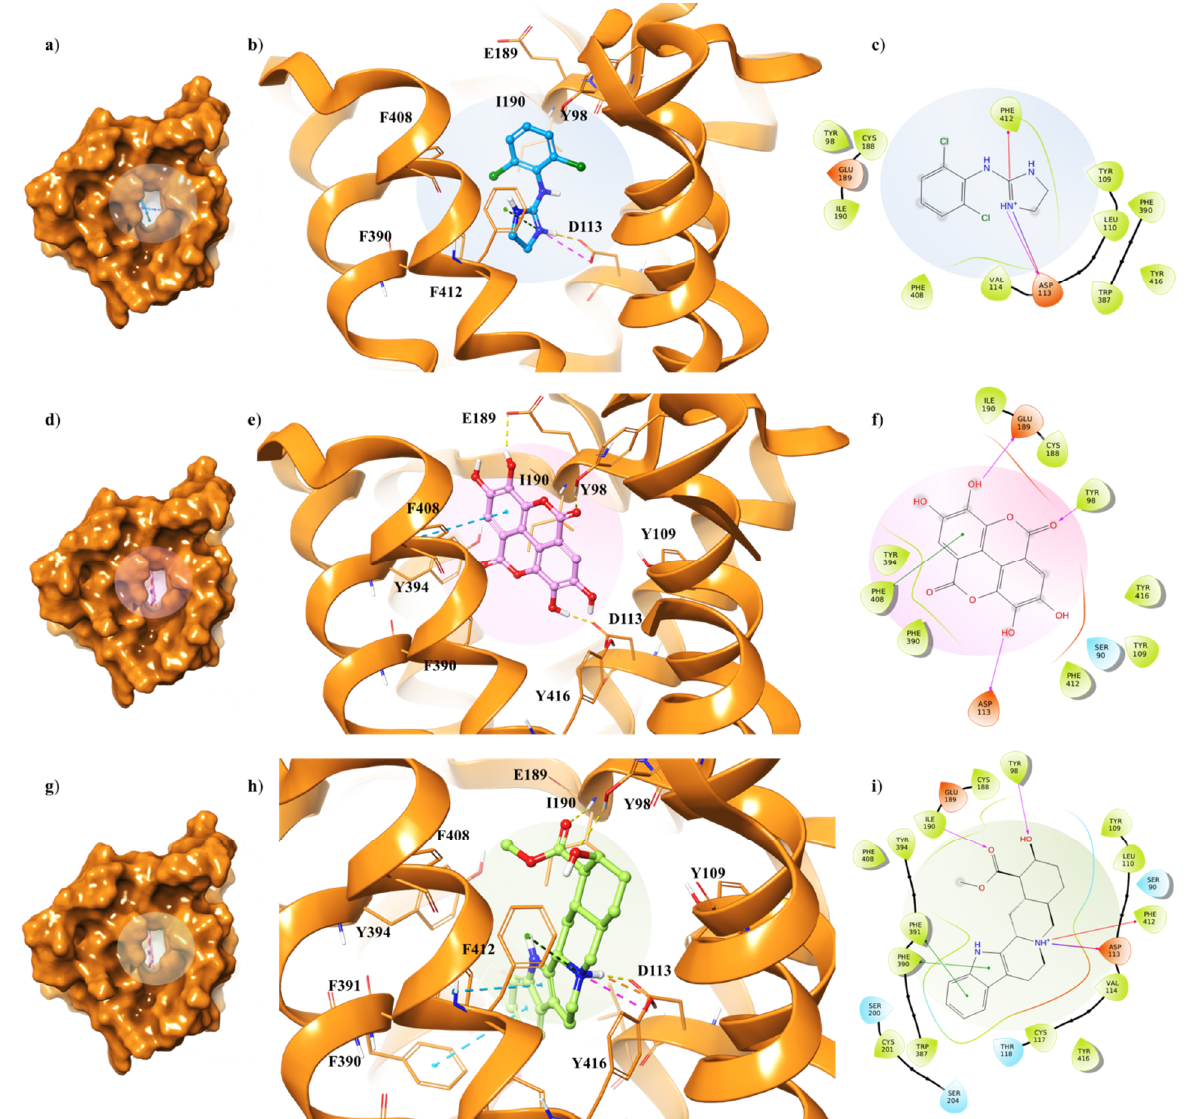
Figure 4. Key contacting elements inside ( a – c ) the α 2A -AR 6KUX /clonidine, ( d – f ) the α 2A -AR 6KUX /EA, and ( g – i ) the α 2A - AR 6KUX /yohimbine best docked pose. Panels ( b,e , h ) show all side chains involved in H-bonds (violet), π-π interactions (cyan) and π-cation interactions (red) in stick representation. Panels ( a , d , g ) show the surface area of α 2A -AR 6KUX complexed to clonidine, EA and yohimbine, respectively. The surface area of the receptor is shown in solid orange solid. 2D representation of the key interactions of ( c ) clonidine, ( f ) EA and ( i ) yohimbine into the α 2A -AR 6KUY structure.